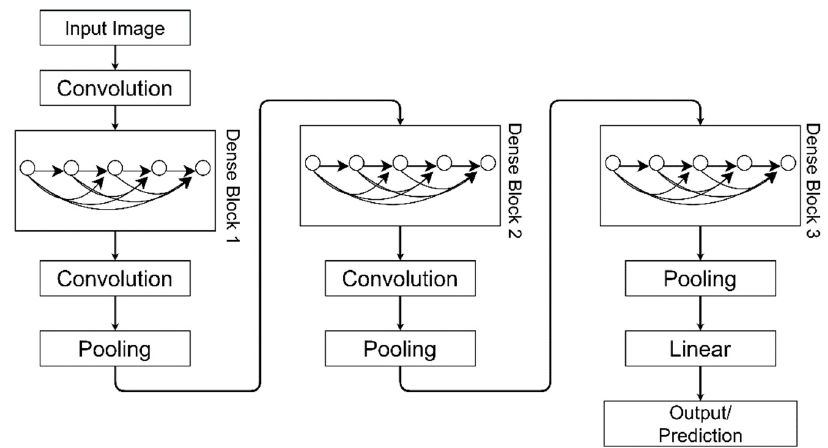
Figure 9. Architecture of DenseNet containing 3 Dense Blocks [33].